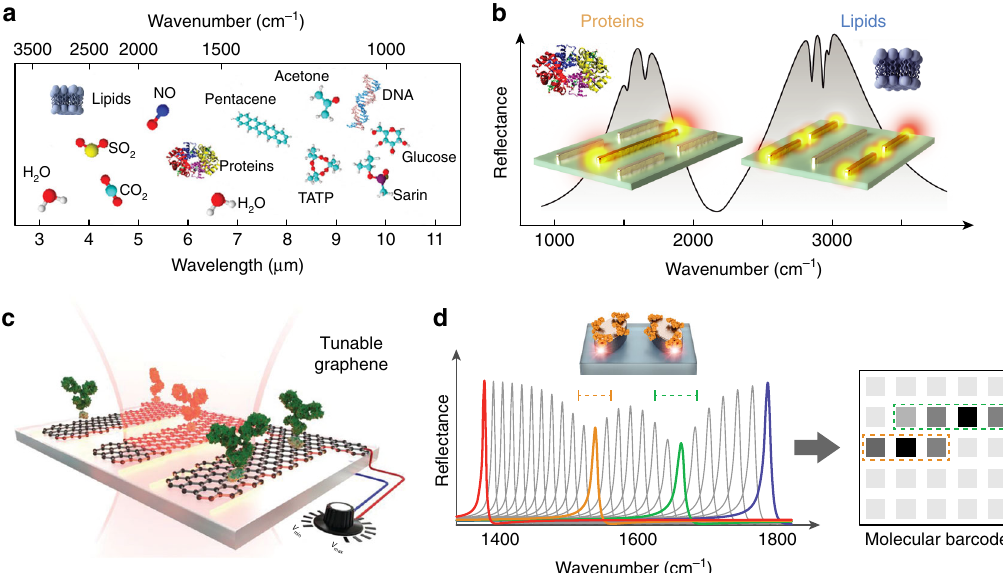
Fig. 2 New directions in surface-enhanced infrared spectroscopy. a The mid-infrared spectral range contains characteristic absorption signatures associated with the vibrational modes of a wide range of molecules and therefore provides rich chemical information. Adapted from ref. 13 with permission. Copyright 2017 American Chemical Society. b Plasmonic nanoantennas can focus IR light into nanoscale volumes to enhance and detect the absorption fi ngerprints of small amounts of molecules on the surface. Multi-resonant antennas simultaneously monitor lipid membranes and protein molecules to unravel their interaction kinetics. Adapted from ref. 17 with permission. c In contrast to static metallic antennas, novel materials such as graphene enable dynamically tunable resonances via external electrostatic biasing. Reprinted from ref. 18 with permission. Copyright 2015, American Association for the Advancement of Science. d High-Q dielectric metapixels can overcome intrinsic metal losses to convert absorption signatures into barcode-like